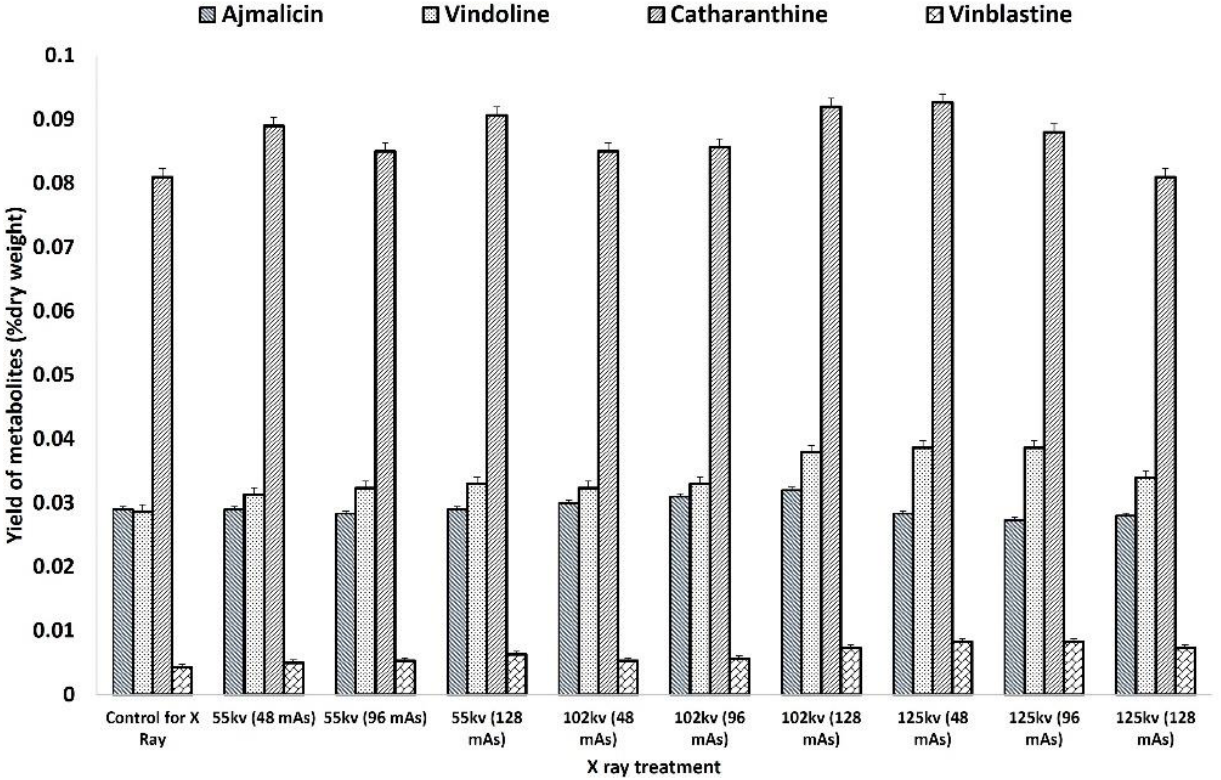
Figure 6. HPLC analysis of the key MIAs ajmalicine, catharanthine, vindoline, and vinblastine in X-ray-mutated M 0 and control C. roseus plants. No significant difference was observed from the respective control at p < 0.05 after applying post hoc Dunnett’s test ( n = 3).